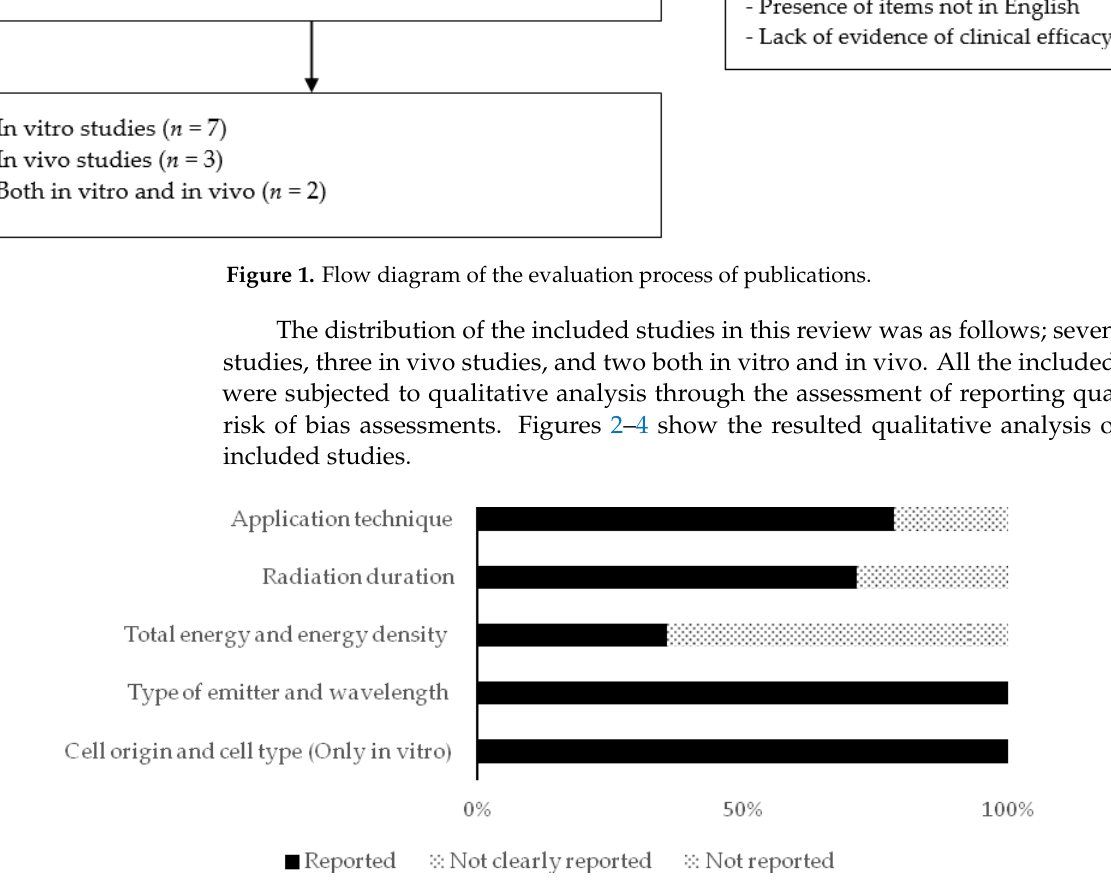
Figure 2. Reporting quality scores in all the included studies ( n = 12) presented in percentages of articles (% of total).